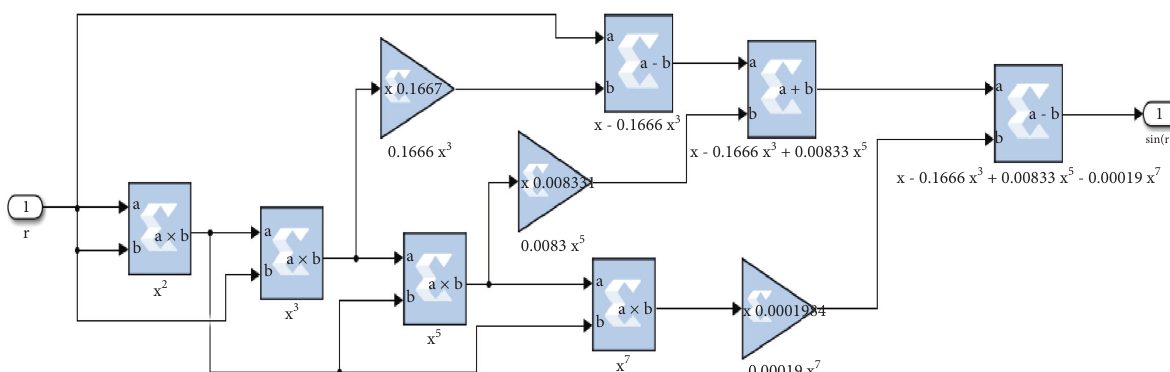
Figure 7: Taylor series of sine function implemented using (XSG) Xilinx system generator toolbox. It is discretized implementation of sine function based on equation (3).